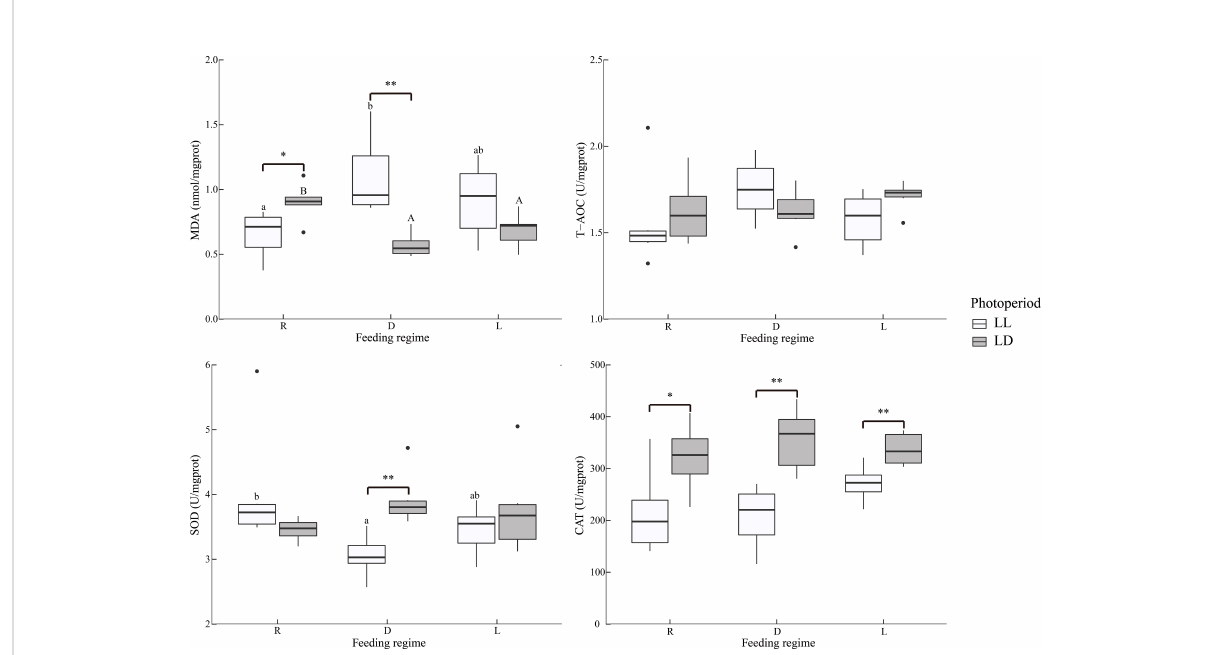
FIGURE 3 Liver antioxidant indicators of juvenile Oncorhynchus mykiss under different experimental treatments (n=6). MDA: Malondialdehyde, T-AOC: Total antioxidant capacity, SOD: Superoxide dismutase, CAT, Catalase; R, random feeding; D, mid-dark stage feeding; L, mid-light stage feeding; LL: 24L: 0D, LD: 12L: 12D. Different lowercase letters and capital letters indicate signi fi cant difference among different feeding regimes at the LL (24L: 0D) and LD (12L: 12D, lights-on at 6:00), respectively ( P < 0.05). Asterisks denote signi fi cant differences between photoperiods at the same feeding regime (* P < 0.05; ** P < 0.01). Points outside the box plot are